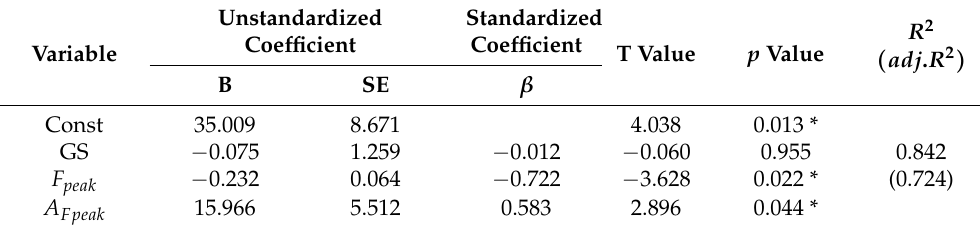
Table 5. Factors related to the realism rating of the removal of roughness (multivariate analysis).